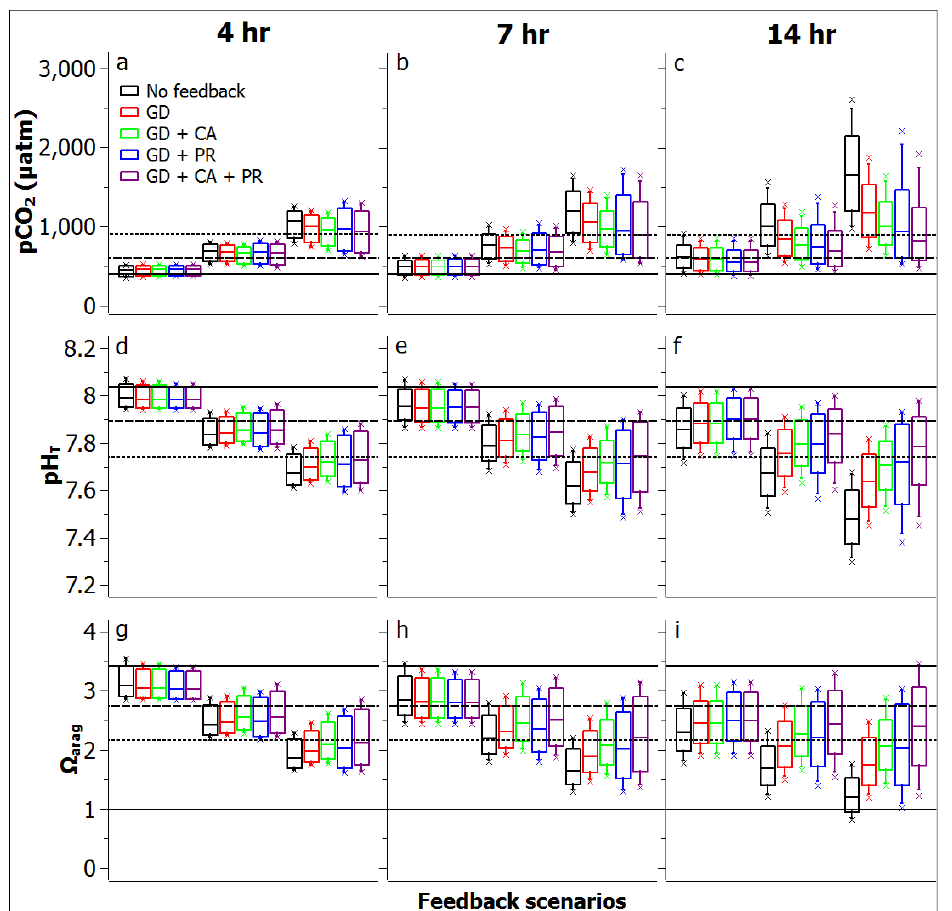
: the five boxes on the left side of each plot plot boxes are arranged by offshore pCO 2 correspond to 400 µatm; the five boxes in the center of each plot correspond to 600 µatm; the five boxes to the right side of each plot correspond to 900 µatm. Thick, black lines in each plot show offshore, seawater chemistry conditions: solid black line = 400 µatm; dashed black line = 600 µatm; dotted black line = 900 µatm. Thin, black line (g – i) shows Ω = arag